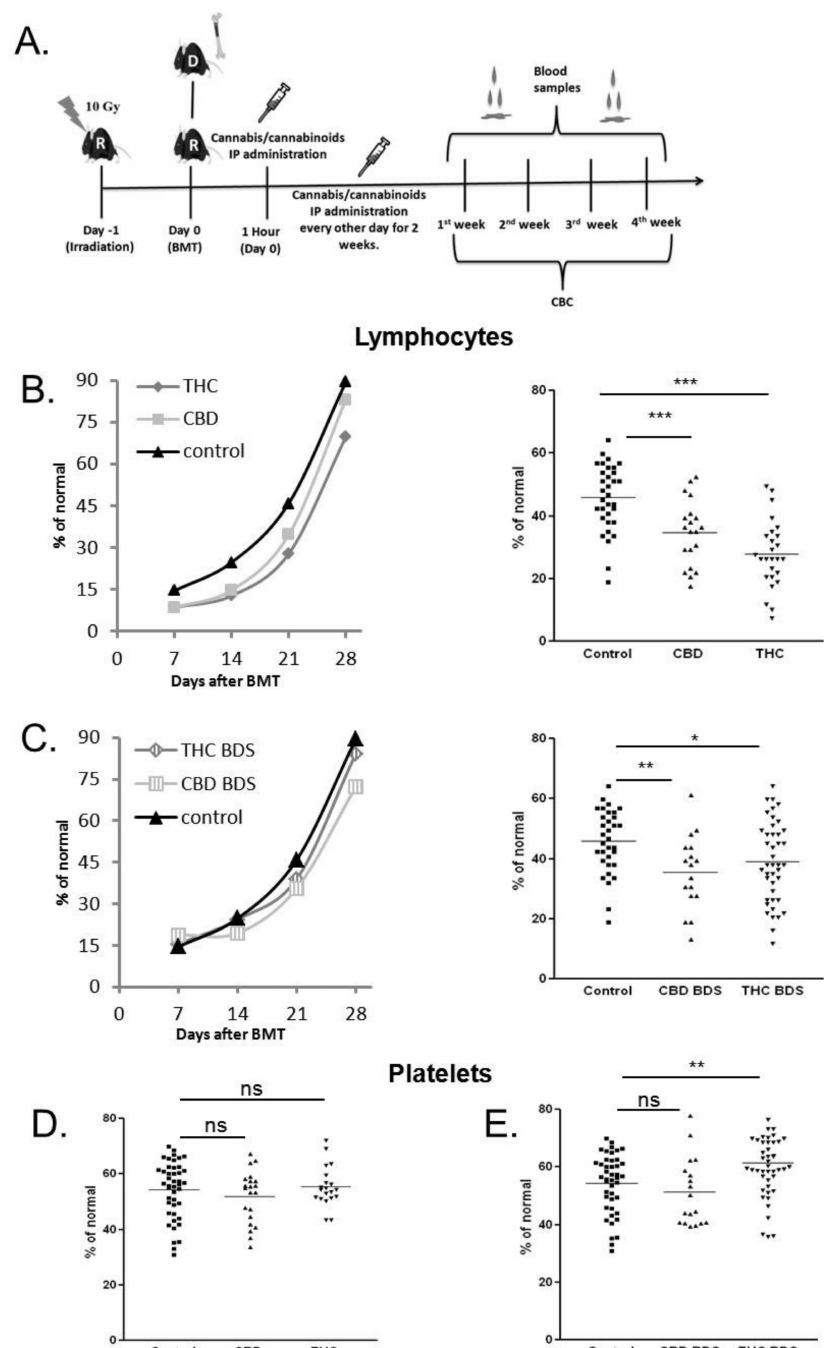
Figure 4. Cannabis/Cannabinoids administration to syngeneic BMT model. ( A ) Recipient C57BL/6 mice received lethal whole-body irradiation and were reconstituted with 8 × 10 6 donor C57BL/6 bone marrow cells. Cannabis/cannabinoids were administered IP every other day, for 2 weeks from the day of transplantation. Blood samples for CBC were obtained once a week. Average lymphocyte counts in pure cannabinoid-treated groups ( B ) and BDS-treated groups ( C ) are presented. Average counts at different time points (left) and day 21 after transplantation counts (right). ( D ) Average platelet counts in pure cannabinoid-treated groups (left) and BDS-treated groups (right), day 14 after transplantation. Data are summarized from four independent experiments (lymphocytes) and three independent experiments (platelets). p Value *, <0.05; **, <0.001; ***, <0.0001. % of normal-% of the mean cell concentrations (cells/ µ L) in healthy C57BL/6 mice, non act: non-activated, act spl: activated splenocytes, THC: D9 tetrahydrocannabinol, CBD: cannabidiol, BDS: Botanical Drug Substance, ns: not